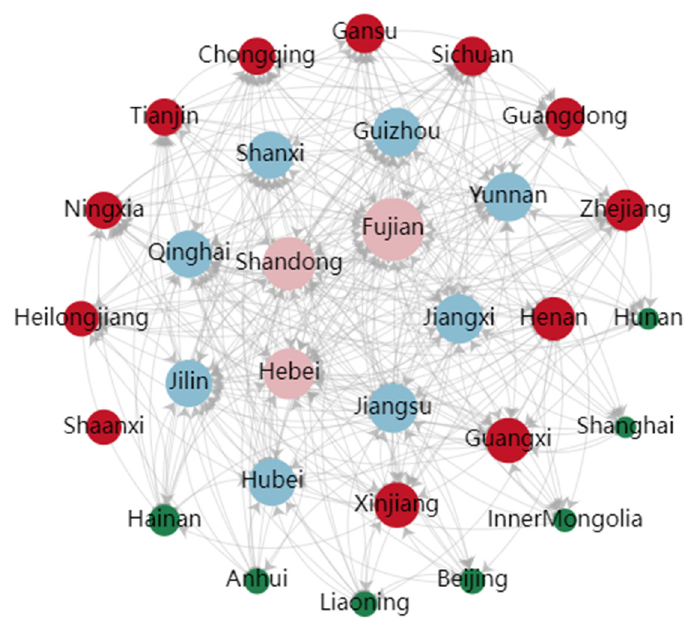
Figure 5. Spatial correlation network of agricultural water use efficiency in China.